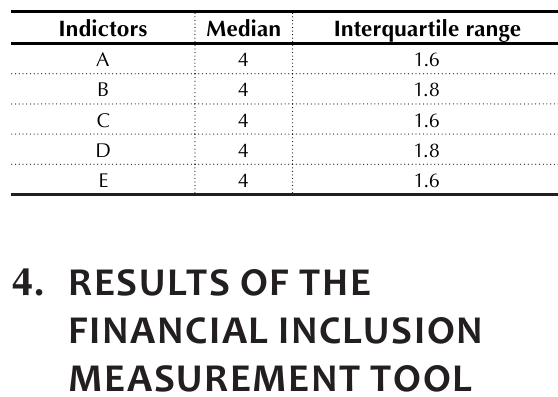
Table 7. Evaluation of the financial inclusion measurement tool